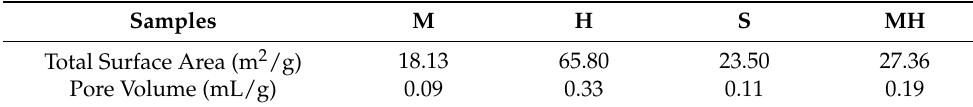
Table 2. Surface properties of the kaolin